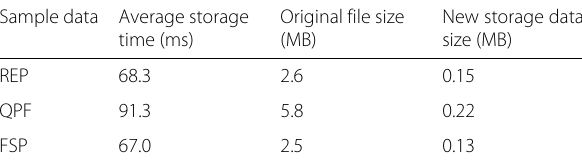
Table 3 Comparison of the storage results for meteorological data